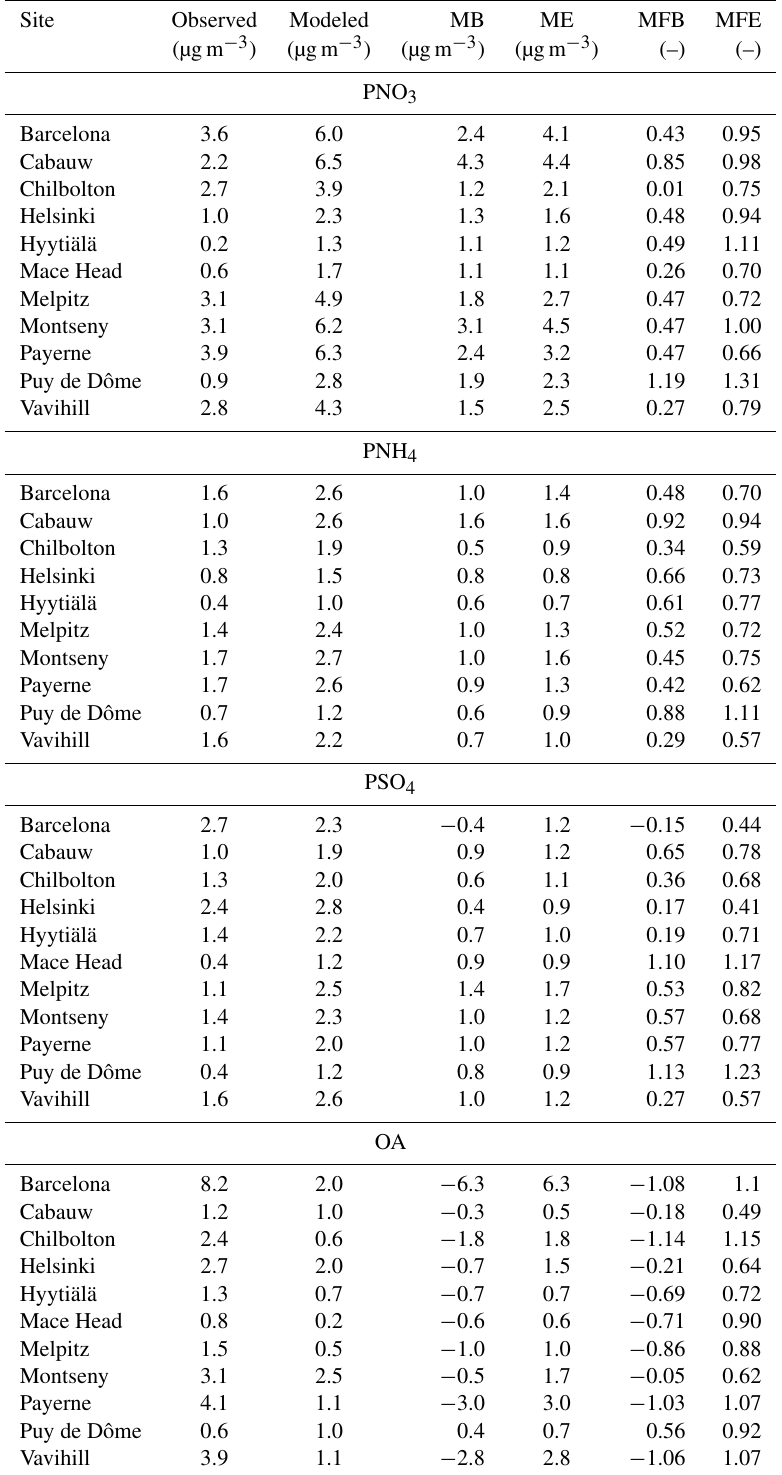
Table 2. Statistical analysis of PNO 3 , PNH 4 , PSO 4 and OA for February–March 2009 at different AMS sites. (MB: mean bias; ME: mean error; MFB: mean fractional bias; MFE: mean fractional